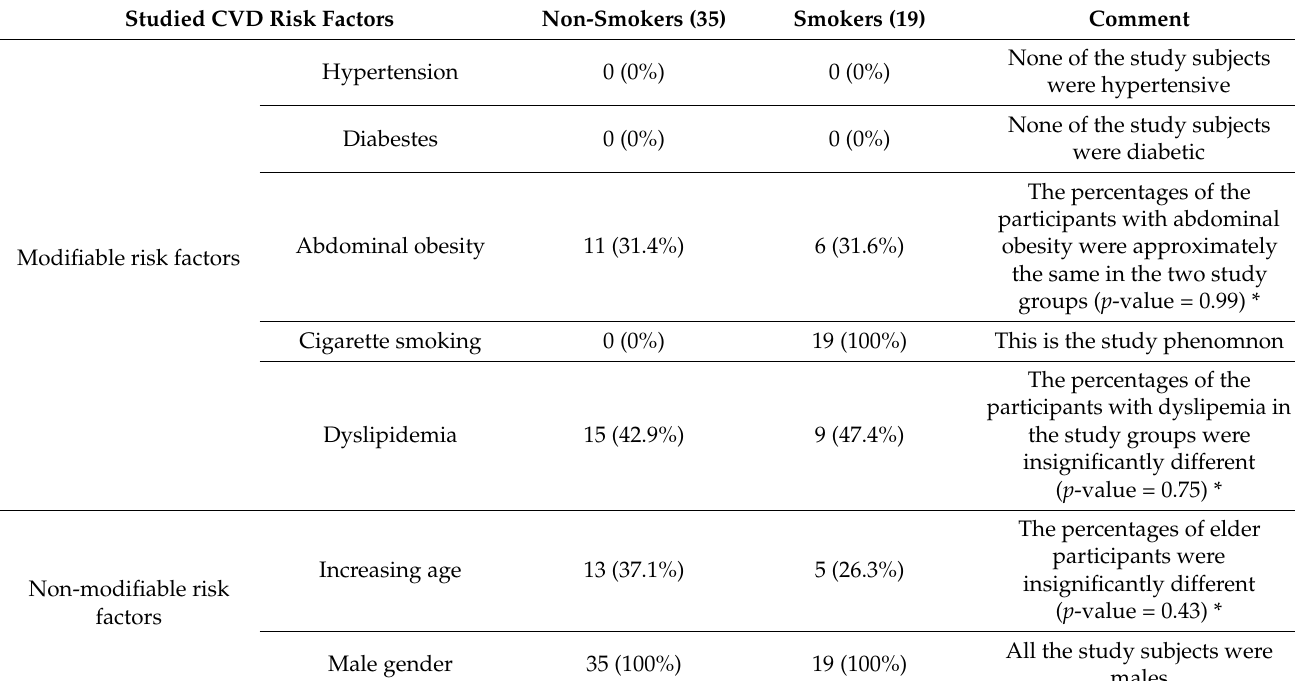
Table 1. Risk factors of CVD in the study